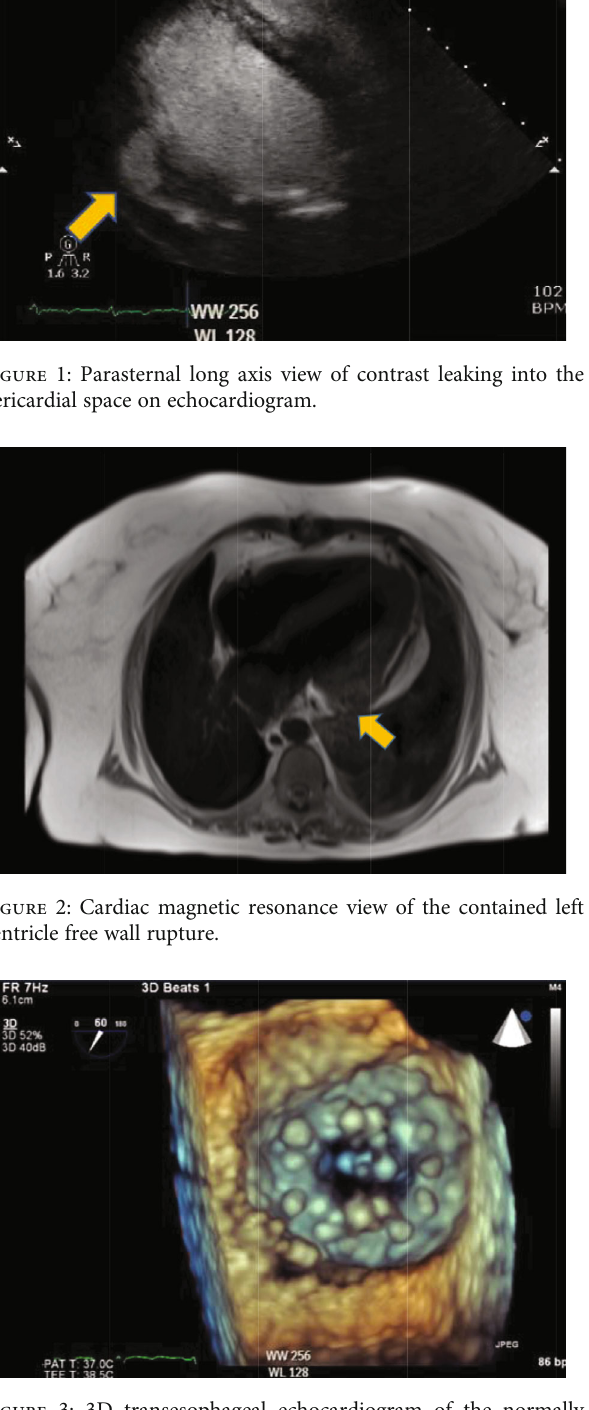
Figure 3: 3D transesophageal echocardiogram of the normally functioning mechanical mitral valve at 60 degrees following treatment with